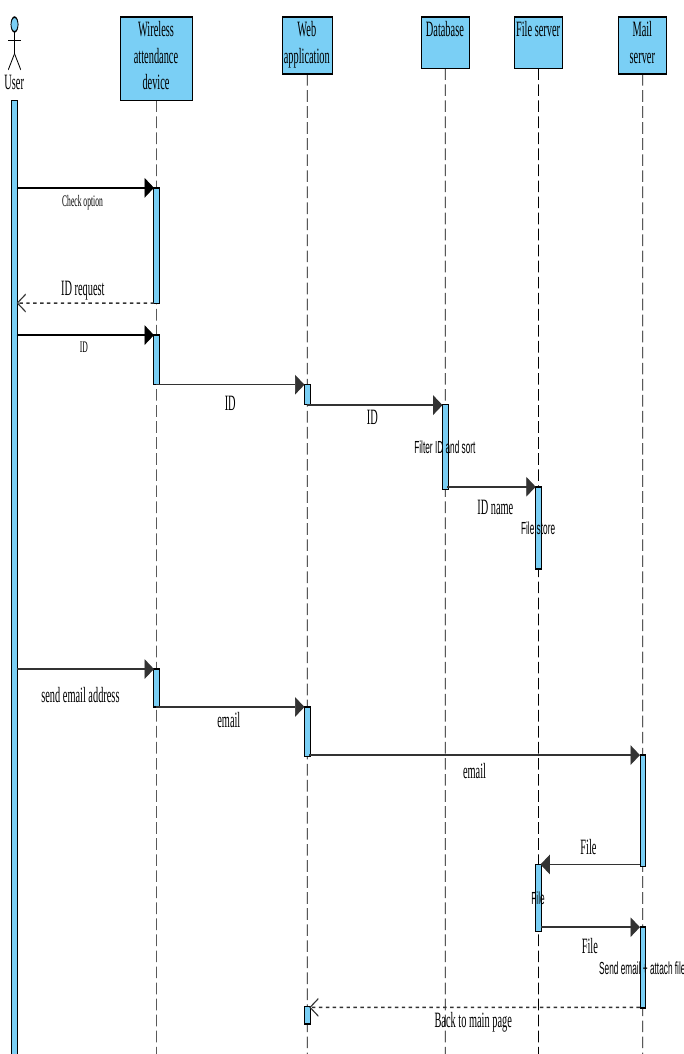
Figure 9. Diagram: inquiring about individual results and sending files to private emails.